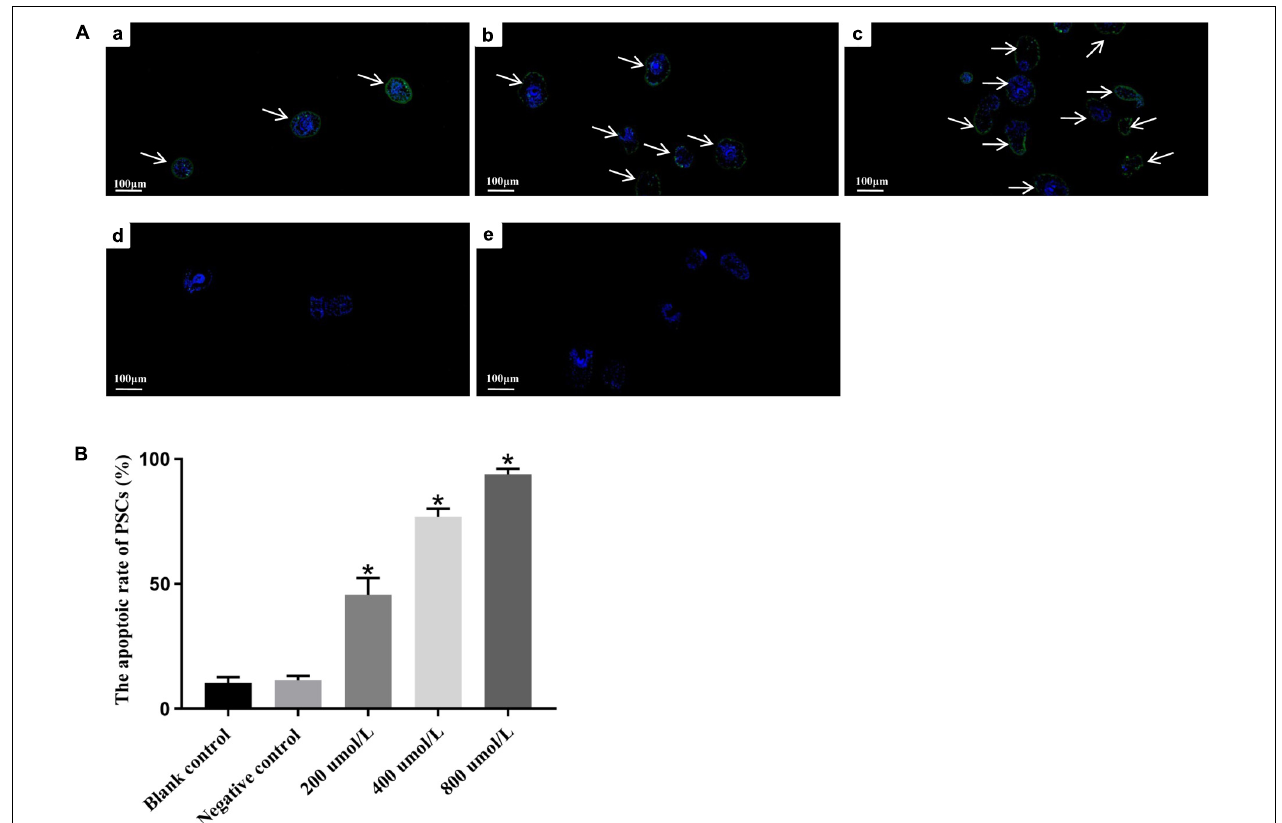
FIGURE 4 | In vitro apoptosis of LCL161 against PSCs determined by TUNEL assay. (A) Fluorescence signals of apoptotic cells in PSCs incubated with LCL161. (a) PSCs of 200 µ mol/L LCL161 group; (b) PSCs of 400 µ mol/L LCL161 group; (c) PSCs of 800 µ mol/L LCL161 group; (d) PSCs of blank control group; (e) PSCs of negative control group. Note, Fluorescence-labeled regions were marked with arrows. (B) The apoptotic rate in PSCs incubated with LCL161 in vitro determined by TUNEL assay. Data are presented as the means ± SD ( n = 3). Statistically significant differences between blank control group and three dosing groups (* p < 0.05), and no significant differences between blank control group and negative control group ( p > 0.05) were determined using Student’s t